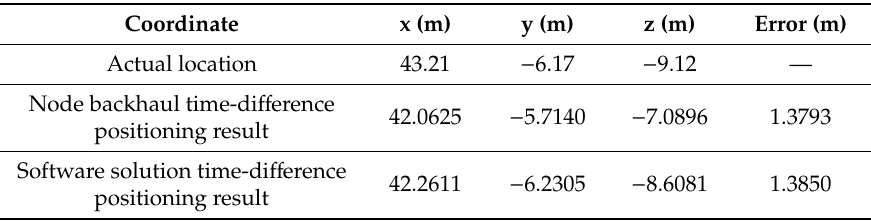
Table 5. Results of location